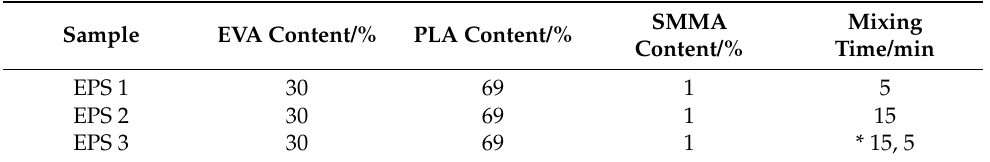
Table 4. Formulations of ternary blends